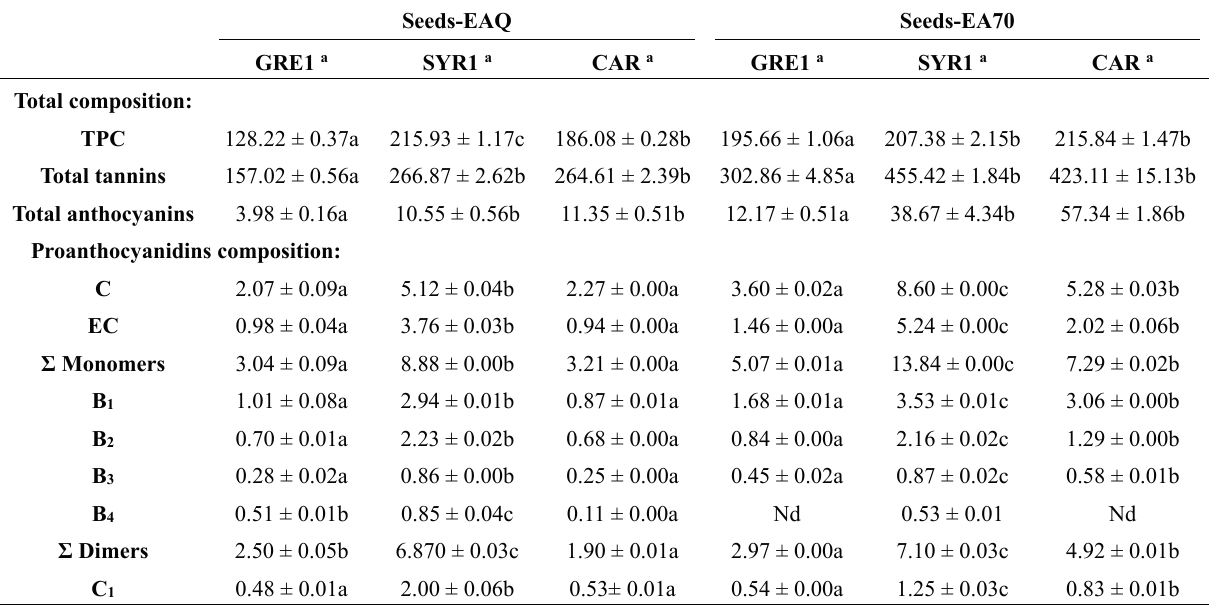
Table 1. Total phenol contents, total tannins, total anthocyanins and flavan-3-ol monomers, dimers and trimer characterisation in EAQ and EA70 grape pomace seed